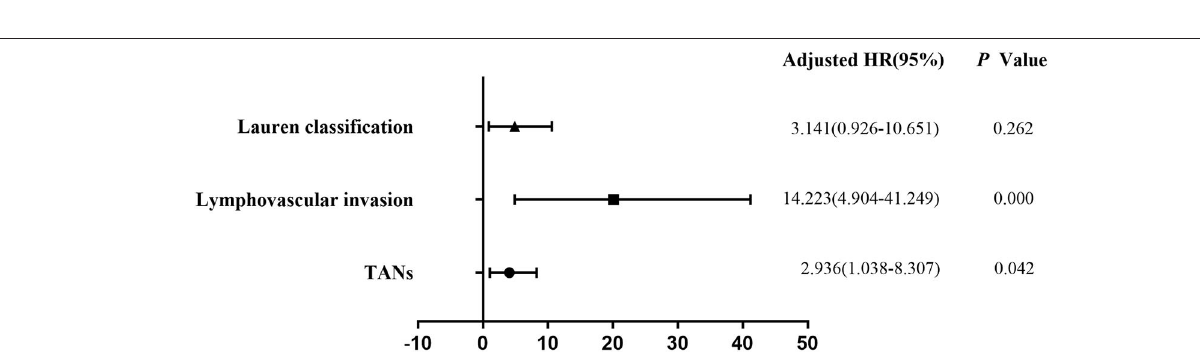
LVI ( P = 0.000), TANs ( P = 0.003), and CAFs ( P = 0.003) ( Supplementary Table S5 ); however, both LVI ( P = 0.000) and TANs ( P = 0.037) were the independent factors ( Figure 3